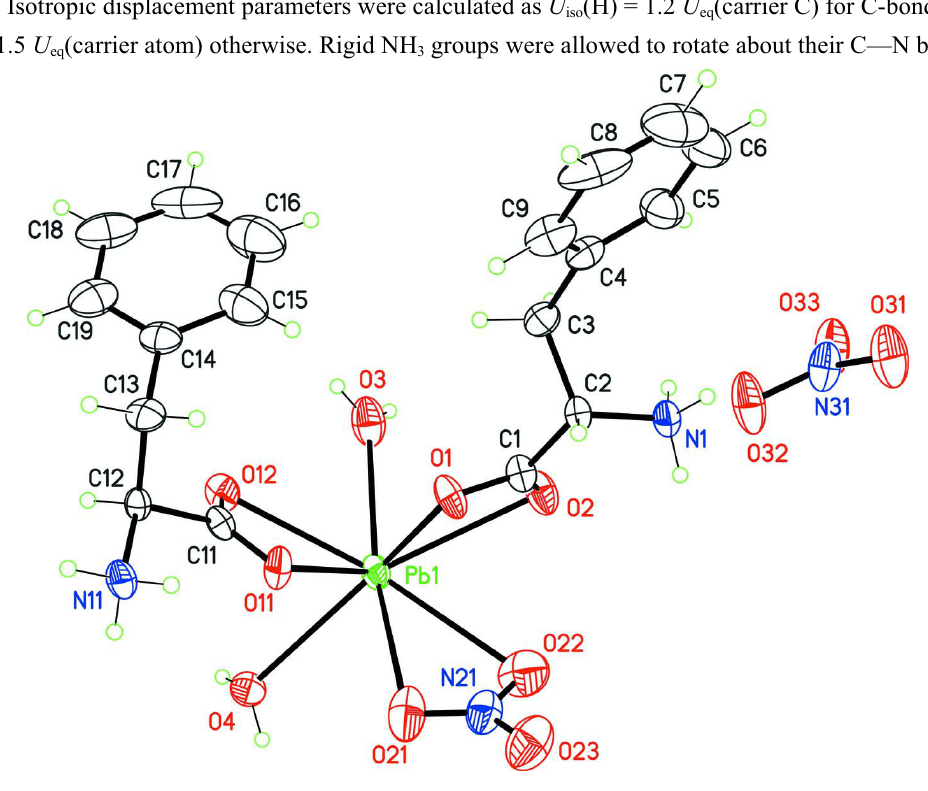
Figure 1 The asymmetric unit of (I) showing the atom numbering scheme, with displacement ellipsoids at the 30% probability